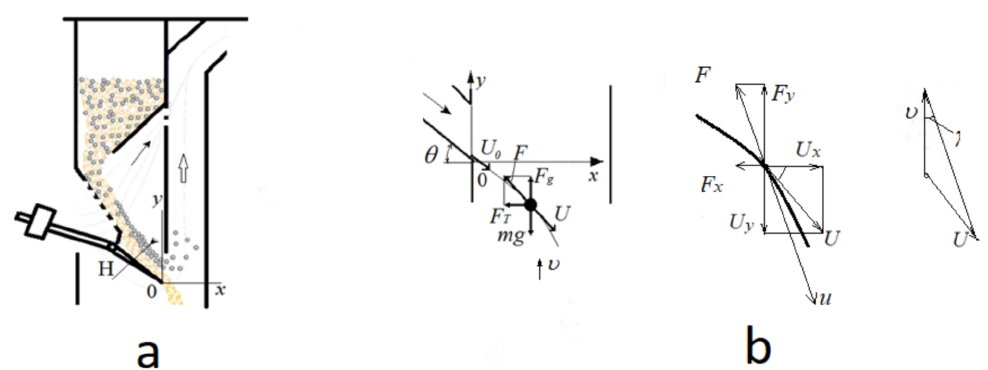
Figure 1. Schematic block of ( a ) vertical pneumatic separation duct with stratification device, and ( b ) schematic block of vertical pneumatic separation duct with stratification device showing forces acting on a particle of the grain mixture and the angle of entry of the particles into the pneumo-separation duct. u is relative speed to the airflow; U is absolute speed of the seed; U 0 is absolute speed at the